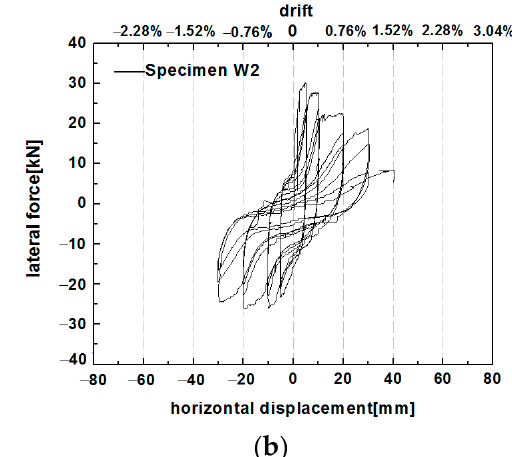
Figure 15. Hysteresis curves of ( a ) specimen W1 and ( b ) specimen W2.